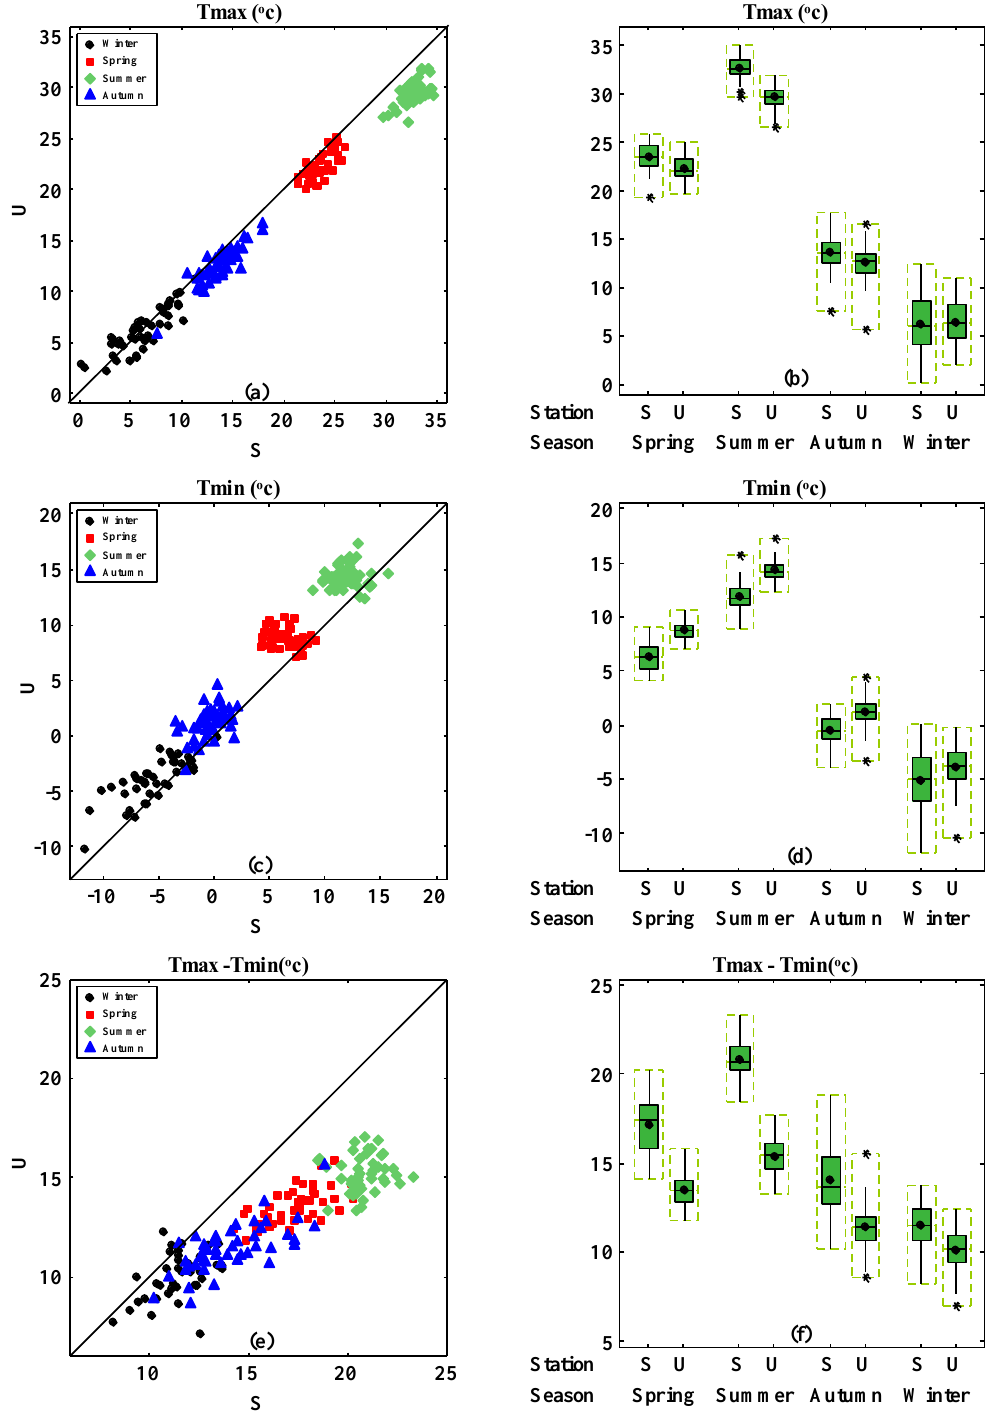
Figure 5. Seasonal patterns in maximum and minimum temperature. Scatterplots of ( a ) maximum temperature ( T max ), ( c ) minimum temperature ( T min ), and ( e ) difference between maximum and minimum temperature ( T max – T min ) in the different seasons at Urmia station (U) and Saqez station (S). ( b , d , f ) The corresponding boxplots.